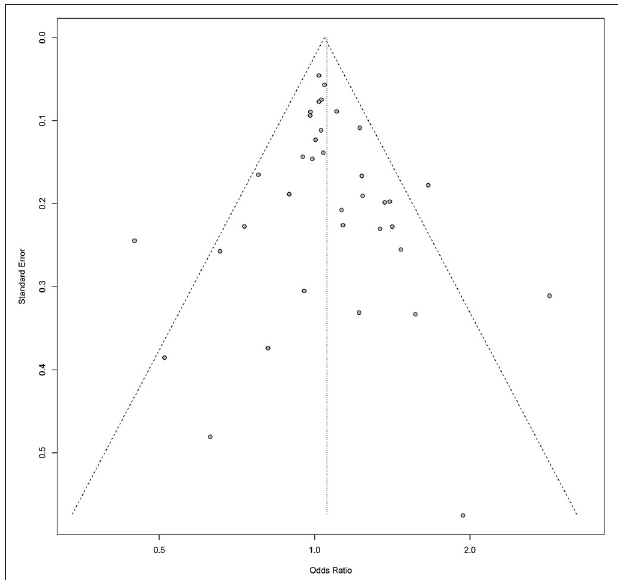
FIGURE 7 | Funnel plot of the association between the AURKA rs2273535 T > A polymorphism and overall cancer risk under the dominant model (AT + AA vs. TT).